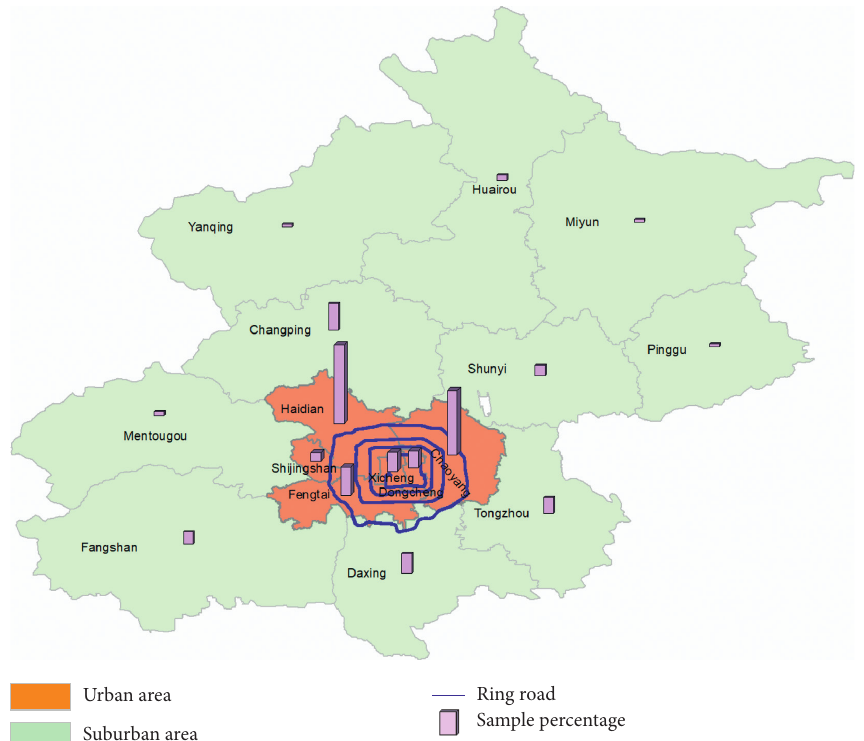
Figure 2: District map of Beijing and samples’ spatial